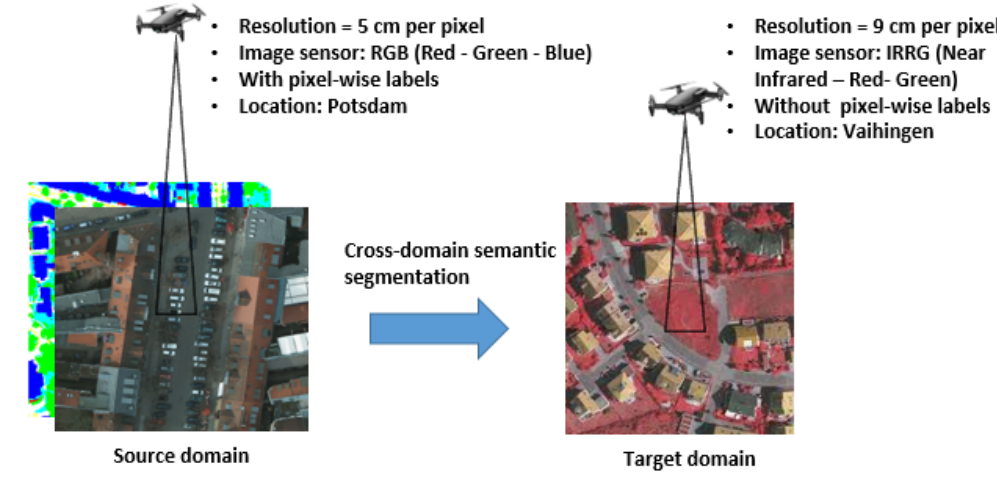
Figure 1. Cross-domain semantic segmentation in aerial